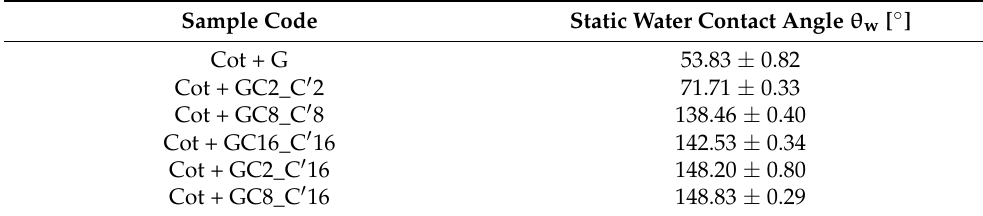
Table 4. Static water contact angles of Wenzel θ w values.